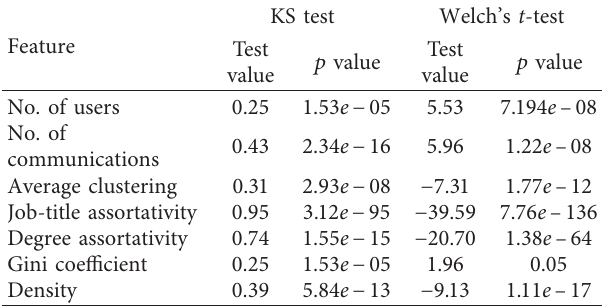
Table 1: Statistical tests comparing the distributions of network features from functional and social communication networks. The Kolmogorov–Smirnov (KS) test measures whether samples come from the same distribution. Welch’s t -test is two-sided and mea- sures whether two distributions have the same average. The dis- tributions and averages significantly differ among functional and social communication networks across all